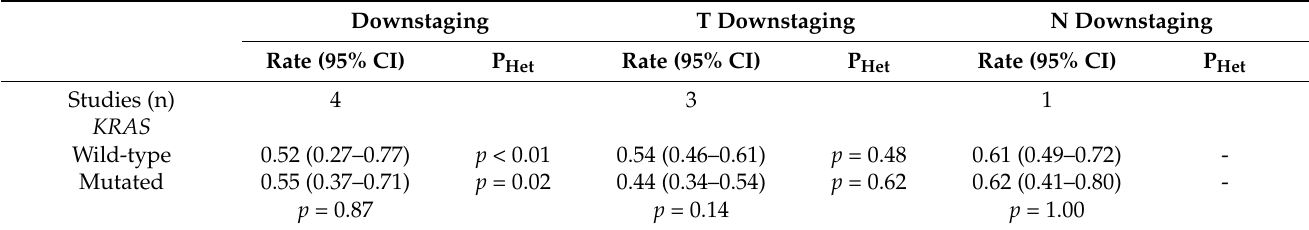
Table 2. Pooled percentage of downstaging according to KRAS mutational status. Downstaging T Downstaging N Downstaging